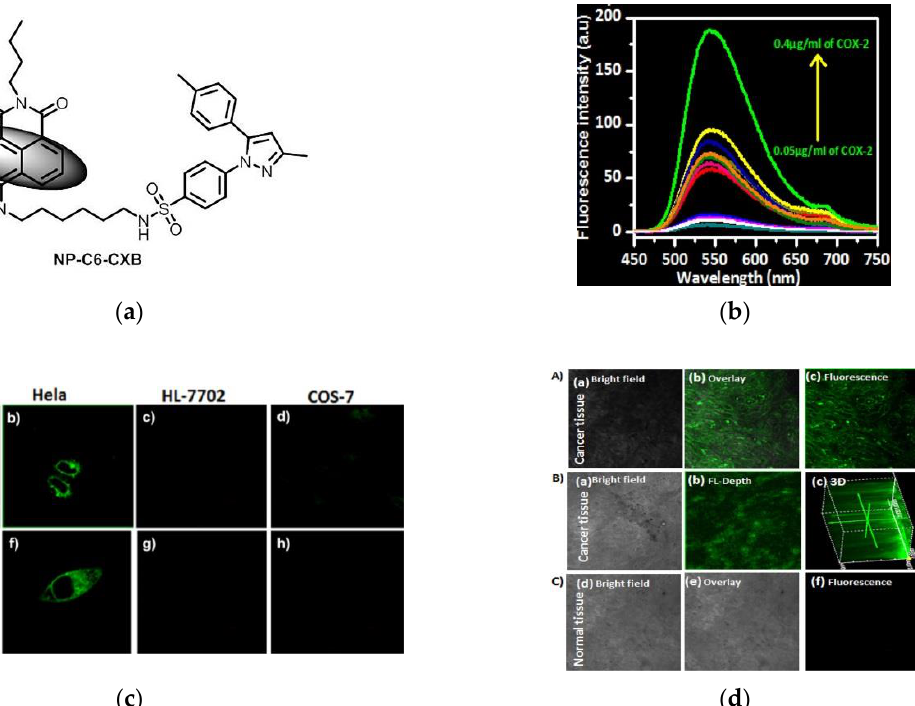
Figure 3. ( a ) Structure of probe NP-C6-CXB; ( b ) Fluorescence spectra of NP-C6-CXB in the presence of COX-2; ( c ) Fluorescent images of live cells under excitation of one-photon and two-photon; ( d ) Fluorescence imaging of cancer and normal tissues. Reproduced with permission from [40].